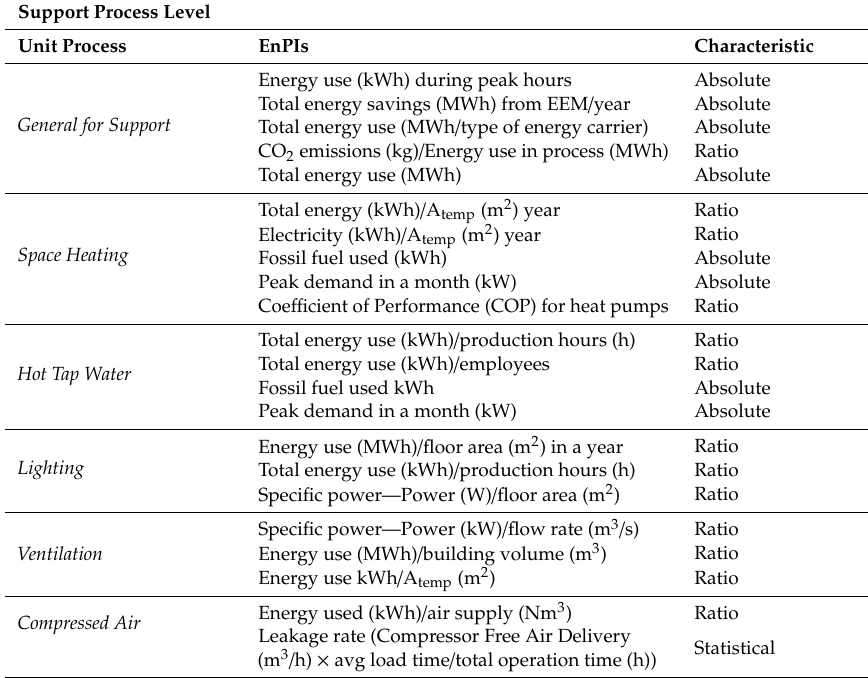
Table 6. Identified EnPIs for support processes for the engineering